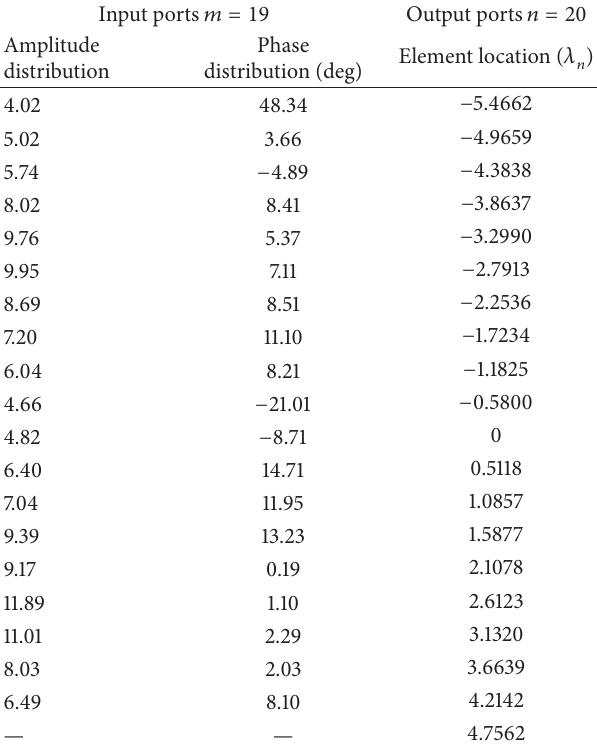
Table 1: Amplitude and phase distributions and element locations for the two-beam configuration shown in Figure